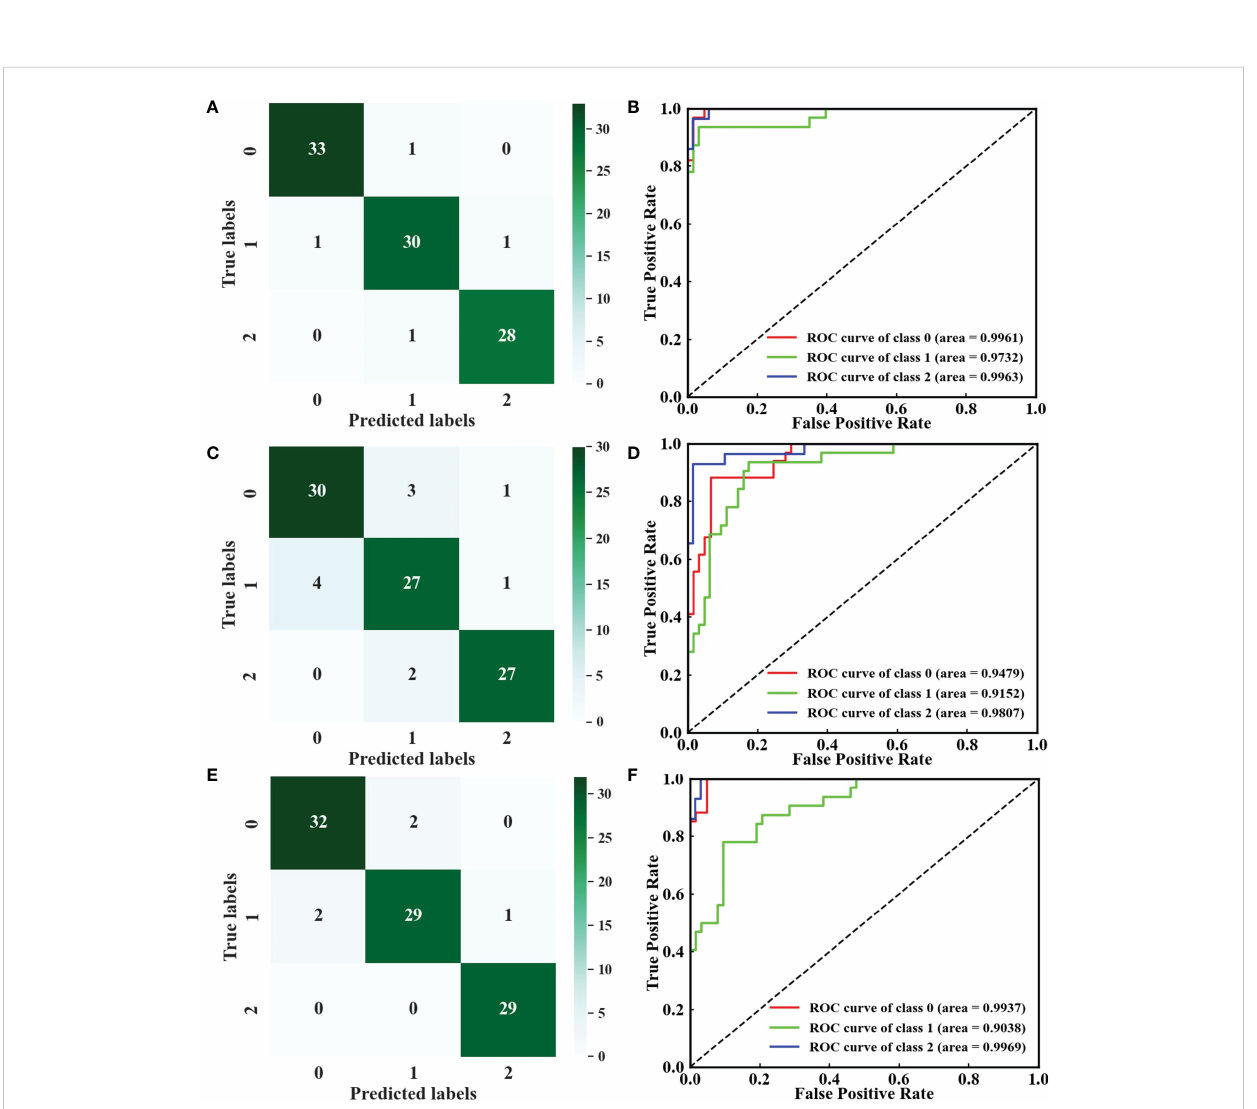
FIGURE 7 Confusion matrices and ROC curves of (A, B) SVM, (C, D) RF, and (E, F) DenseNet. Classes 0 – 2: well-watered, reduced-watered, and de fi cient- watered tomato plants,